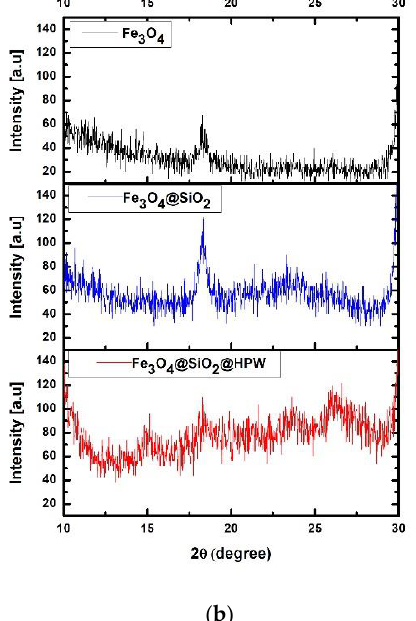
Figure 7. XRD patterns of Fe 3 O 4 , Fe 3 O 4 @ SiO 2 , and Fe 3 O 4 @ SiO 2 @HPW ( a ) 2θ = 10–80°; ( b ) 2θ = 10–30° .